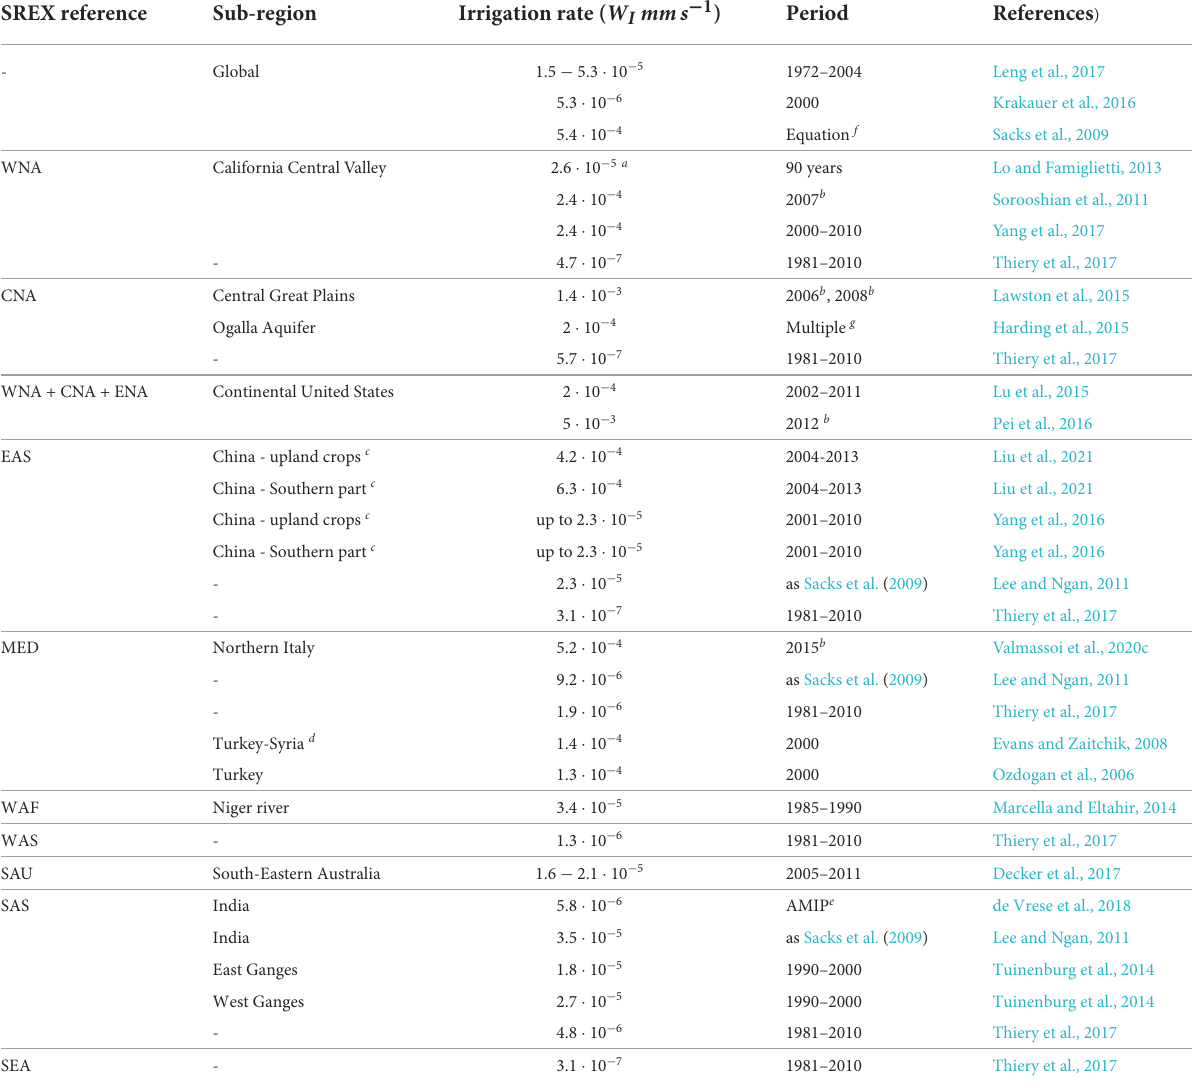
TABLE 5 Table with the irrigation rates ( W I ) of the different studies including the derived amounts from the available